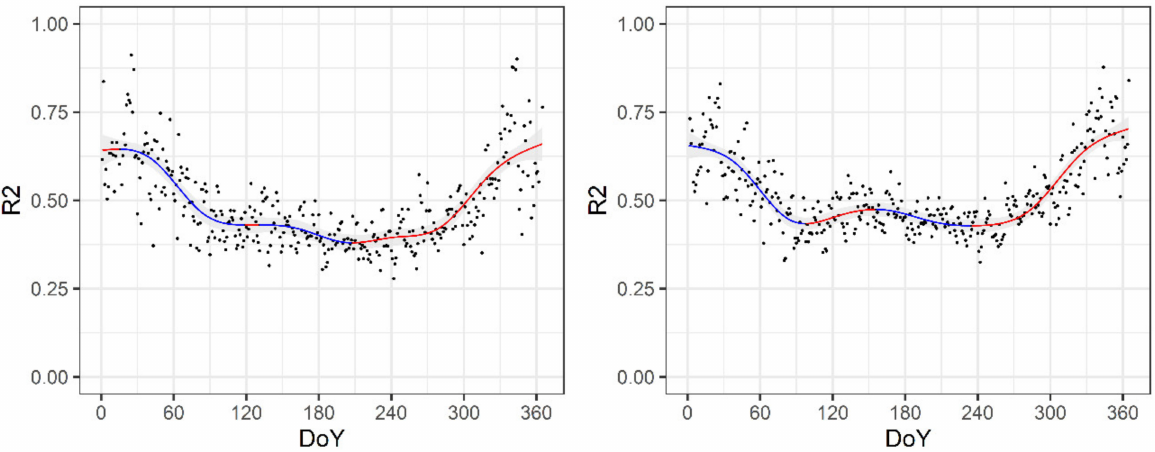
Figure 13. Seasonal variation of R 2 in apple orchard (NS/CE; ( left )) and winter wheat/sugar beet canopy (NS/TE; ( right )).